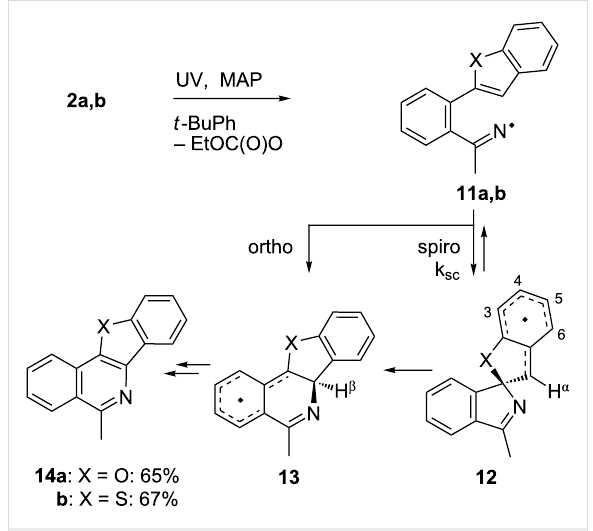
not consistent with structure 13 , which was not spectroscopic- ally detected. It is evident therefore that iminyl radical 11a rapidly and selectively undergoes spiro-cyclisation with the benzofuran